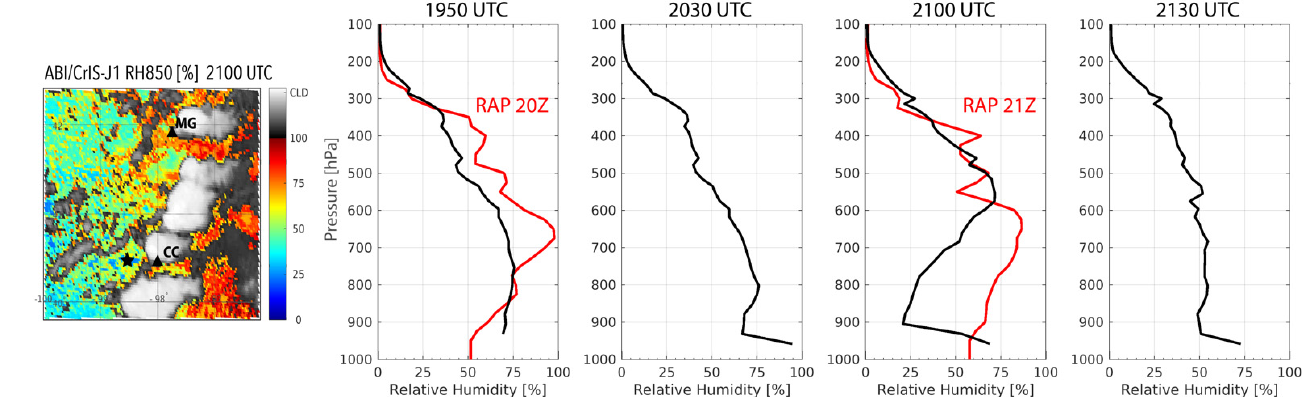
Figure 7. ABI/CrIS-J1 RH fusion profiles at 1950 (JPSS-1 overpass time), 2030, 2100, and 2130 UTC at 40.48° N 98.74° W (indicated by a black star in the left plot showing the 850 hPa RH fusion results at 2100 UTC as in Figure 6), about 45 km west of Clay Center (CC). Fusion profiles are shown in black, and the RAP 2 h forecast RH profiles valid at 2000 and 2100 UTC are shown in red.